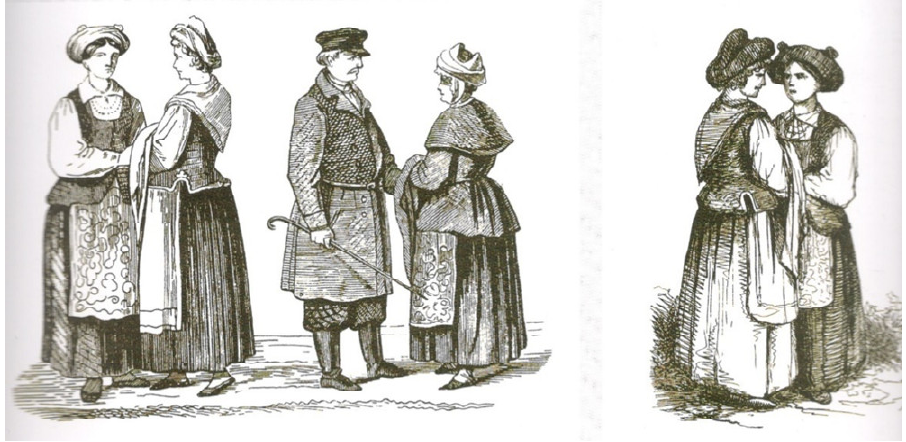
Figure 1. People from Mikališkės town [48].